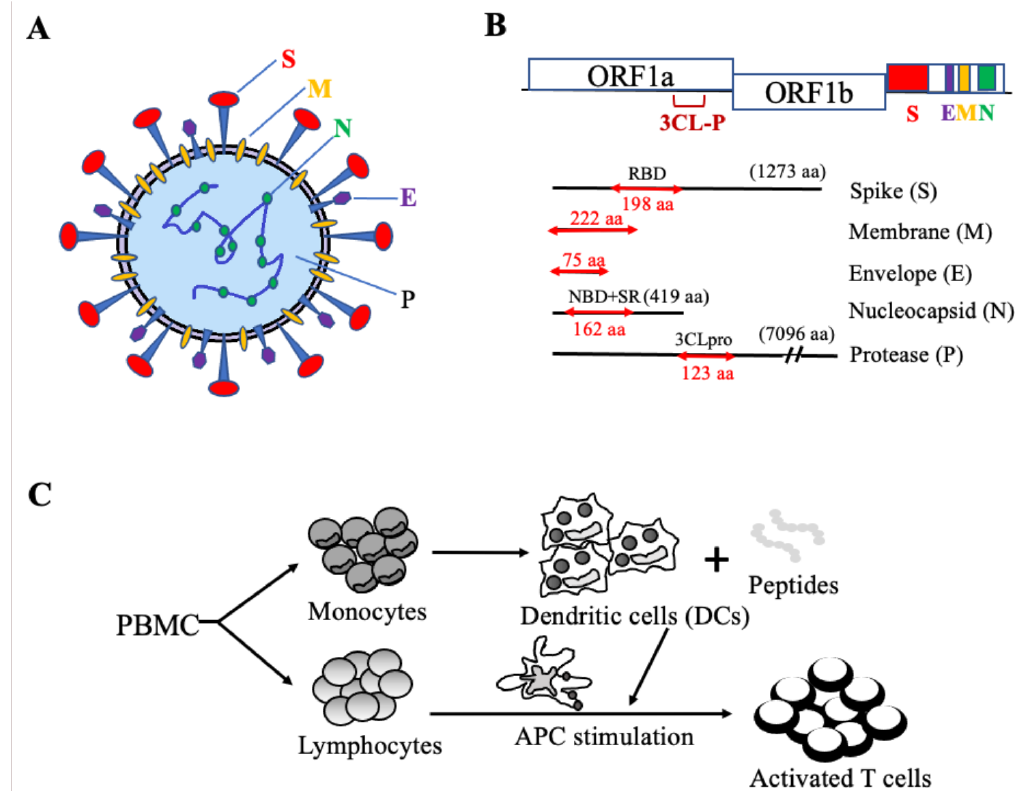
Figure 1. Synthetic peptides of SARS-CoV-2 S, E, M, N, and P proteins and in vitro generation of antigen-specific T cells. ( A ) Schematic illustration of SARS-CoV-2 particle. ( B ) Representative S, E, M, N, and P protein domains. ( C ) Diagram of in vitro antigen-specific T cell generation. DCs and T lymphocytes were prepared from PBMCs and synthetic viral peptide-pulsed DCs were used as antigen presenting cells (APCs) to activate T